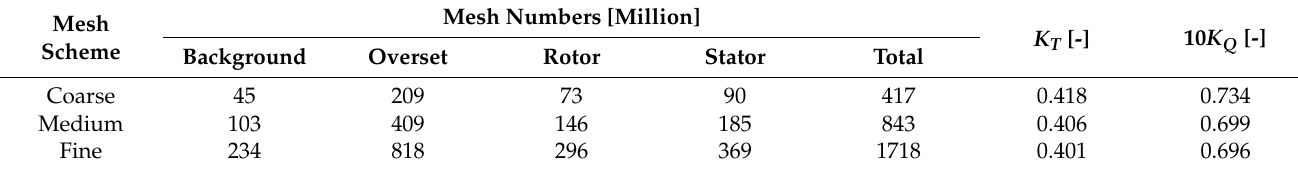
Table 4. The grid numbers and numerical simulation results of these three mesh schemes. Mesh